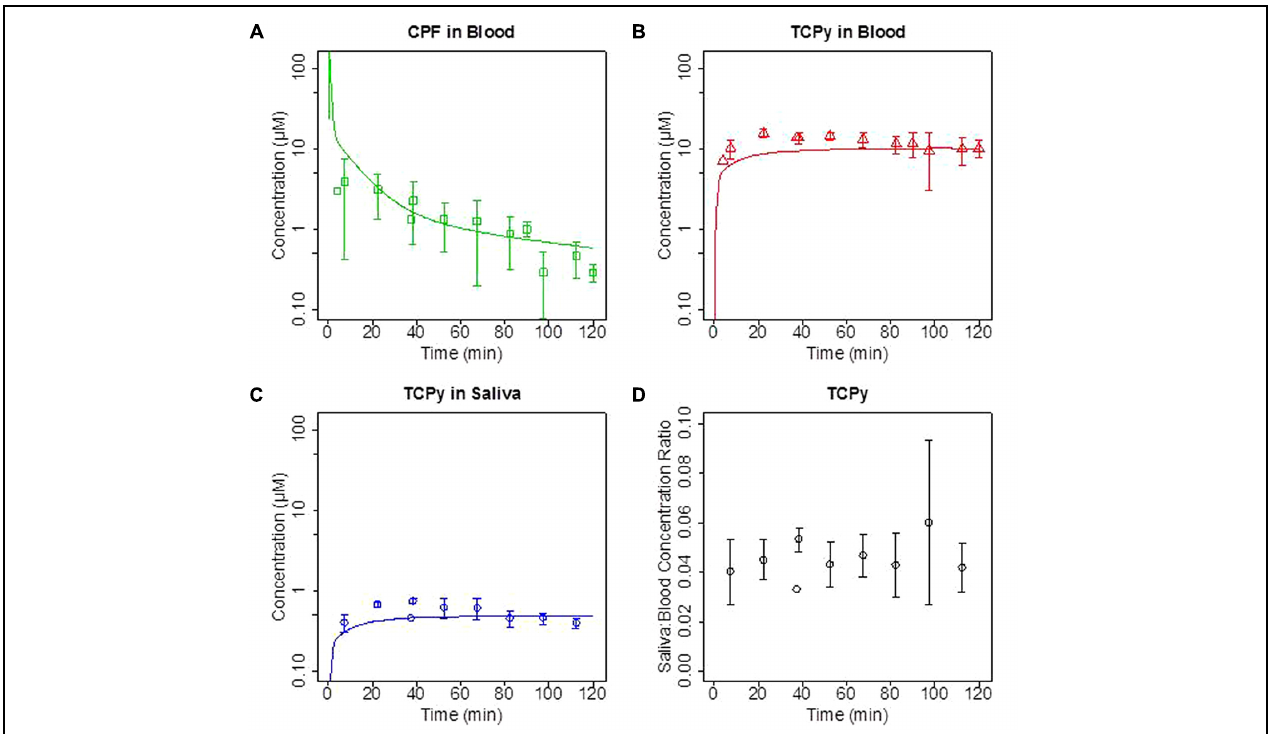
FIGURE 3 | Groups of rats were administered a single intravenous (IV) dose of 5 mg/kg chlorpyrifos ( CPF ). (A) Concentration ( μ M) of CPF in blood; (B,C) trichloropyridinol ( TCPy ) in blood and saliva, respectively; and (D) saliva:blood TCPy concentration ratios from 10–120 min post-dosing. Lines are PBPK model fit to